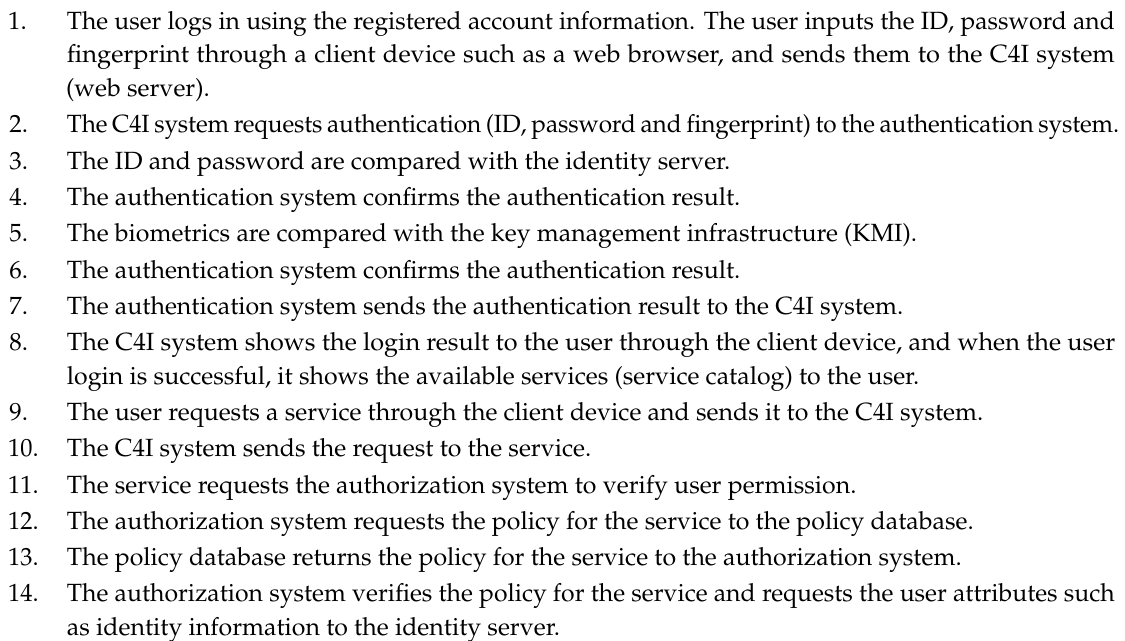
Figure 6. Sequence Diagram of Authentication and Access Control for Cloud-based C4I System.